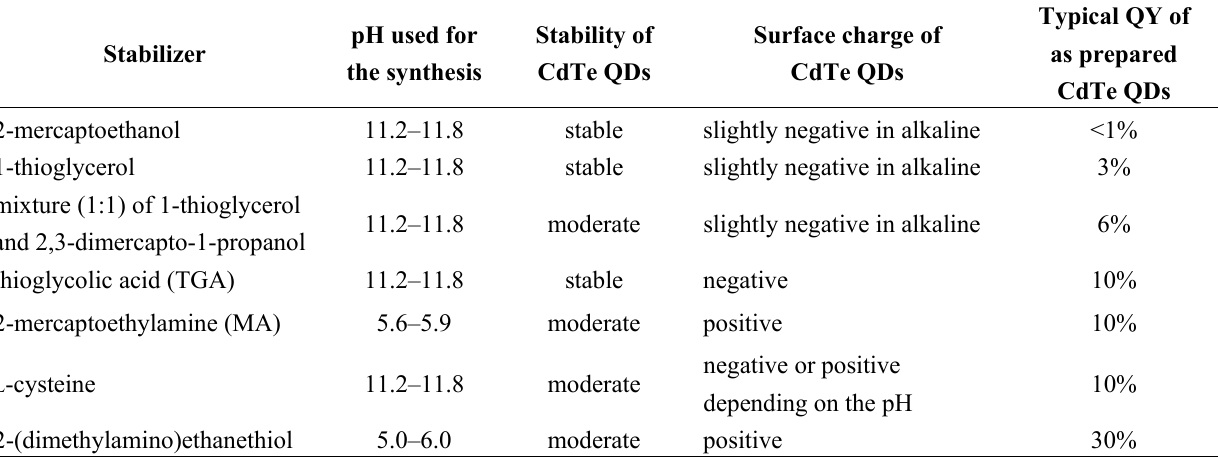
Table 1. Conditions for the aqueous synthesis of CdTe nanocrystals and their properties [16]. Copyright 2002 American Chemical Society. Typical QY of pH used for Stability of Surface charge of Stabilizer as prepared the synthesis CdTe QDs CdTe QDs CdTe QDs 2-mercaptoethanol 11.2–11.8 stable slightly negative in alkaline <1% 1-thioglycerol 11.2–11.8 stable slightly negative in alkaline 3% mixture (1:1) of 1-thioglycerol 11.2–11.8 moderate slightly negative in alkaline 6% and 2,3-dimercapto-1-propanol thioglycolic acid (TGA) 11.2–11.8 stable negative 10% 2-mercaptoethylamine (MA) 5.6–5.9 moderate positive 10% negative or positive 10% L -cysteine 11.2–11.8 moderate depending on the pH 2-(dimethylamino)ethanethiol 5.0–6.0 moderate positive